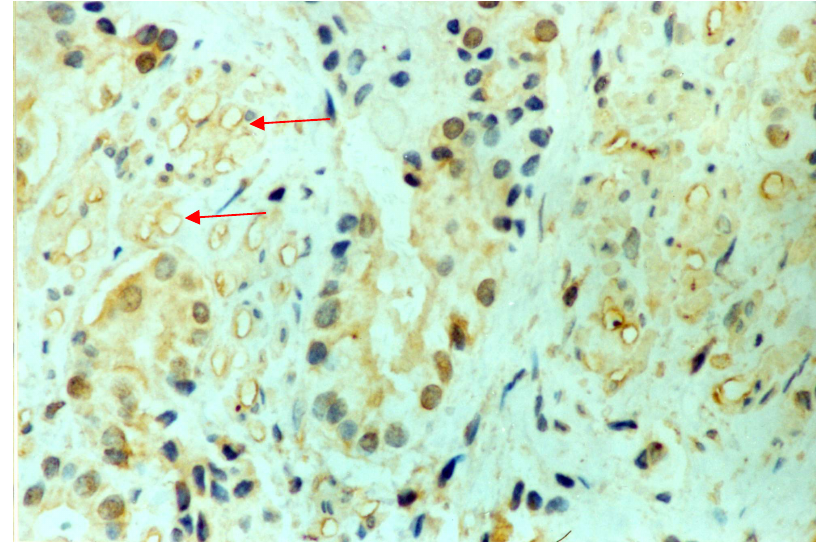
Figure 3. Photomicrograph showing immunohistochemical staining of VEGFR-3 in cells of prostate cancer tissue. Arrows indicate high intratumoral microlymphatic density (EnVisionTM, magnification